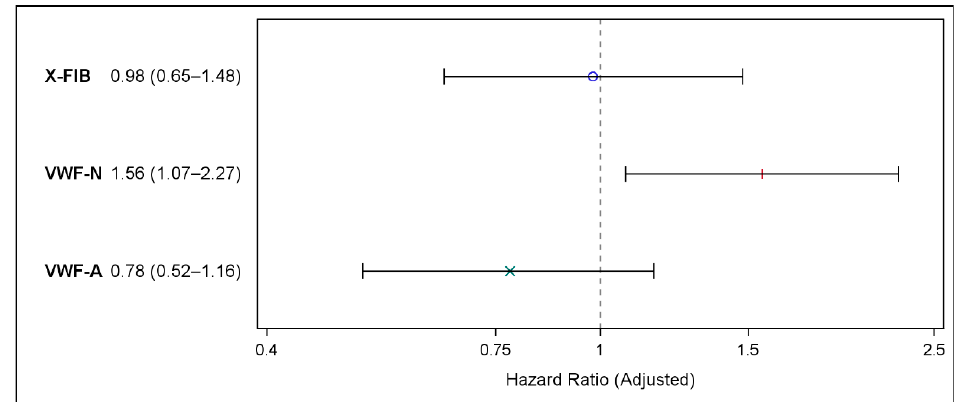
Figure 4. Forest plot showing the results of the multivariable Cox proportional hazards regression on risk of major cardiovascular events for X-FIB, VWF-N, and VWF-A; Hazard Ratio (95% confidence interval). Adjusted for age, sex, forced expiratory volume in one second (% of predicted), former ischemic heart disease, former heart failure, atrial fibrillation/flutter, hypertension, hypercholesterolemia, peripheral vascular disease type 2 diabetes, smoking status, and ICS use. ◦ : X-FIB HR estimate, |: VWF-N HR estimate, × : VWF-A HR